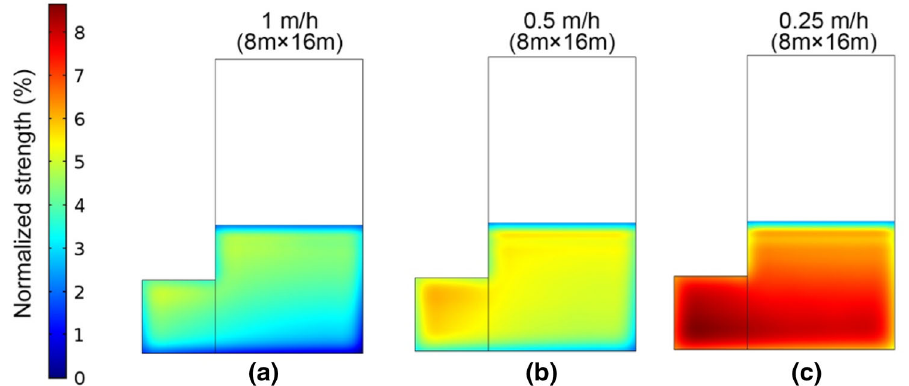
Fig. 22 Effect of filling rate on spatial distribution of early-age strength of CPB after curing of plug layer: a 1 m/h, b 0.5 m/h, and c 0.25